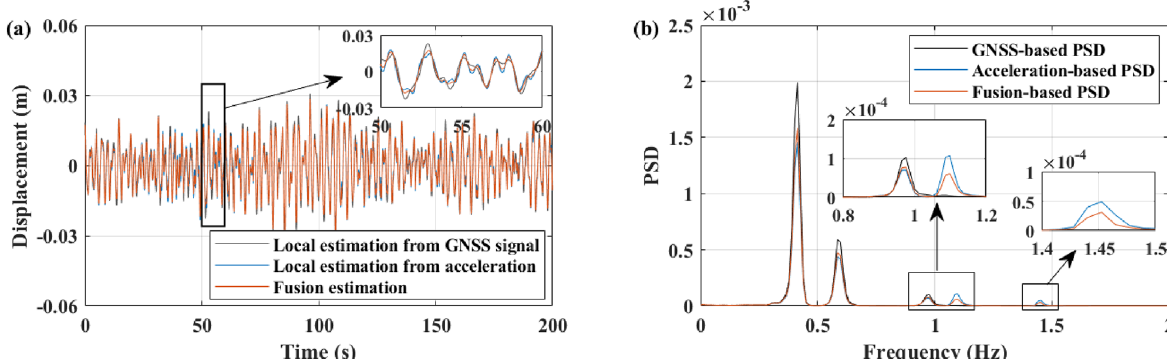
Fig. 12 Estimated displacements and the corresponding PSD functions